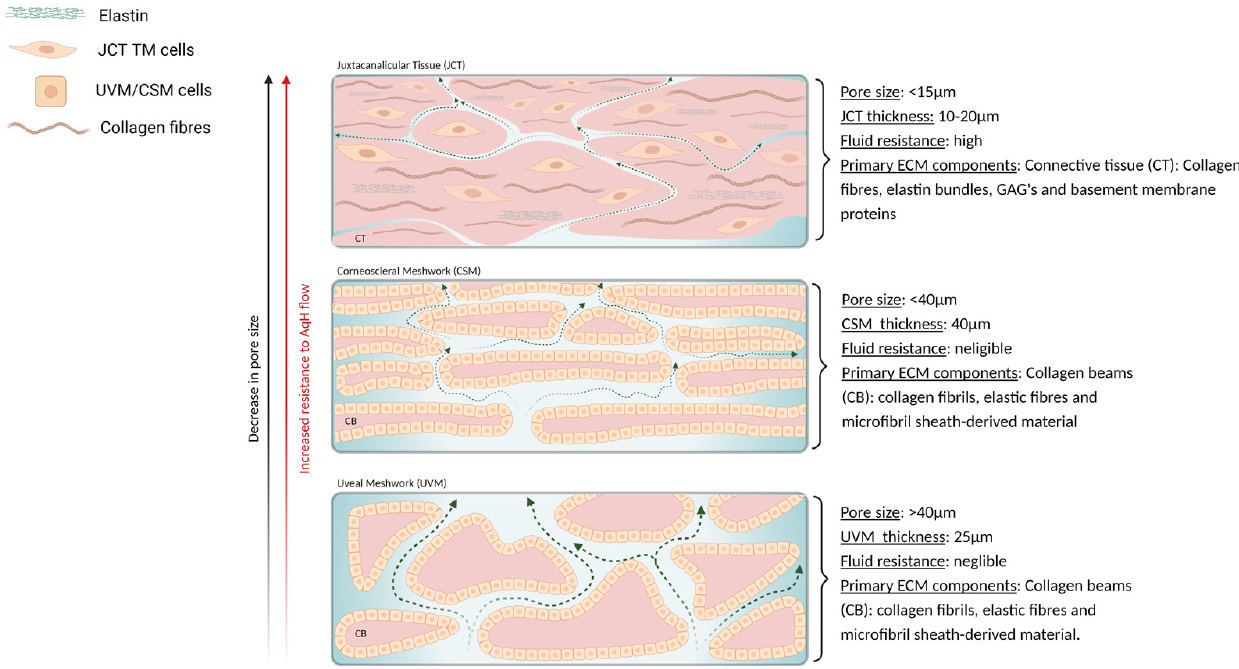
Figure 2. Schematic of TM structure and AqH flow. A differing structure is presented within each section of the TM tissue, with dotted arrows indicating direction of AqH outflow. UVM: The outermost section of the TM consists of randomly orientated collagen beams (CB) and larger pore size than other segments. CSM: Collagen beams become progressively thinner and more striated going deeper into the TM tissue; collagen beams run parallel to the Schlemm’s canal, and contain a markedly reduced pore size compared to the UVM. JCT: Deepest portion of the TM tissue has a contrasting structure to UVM and CSM, consisting of layers of connective tissue with cells embedded within the tissue, and comparatively small pore size (<20 µ